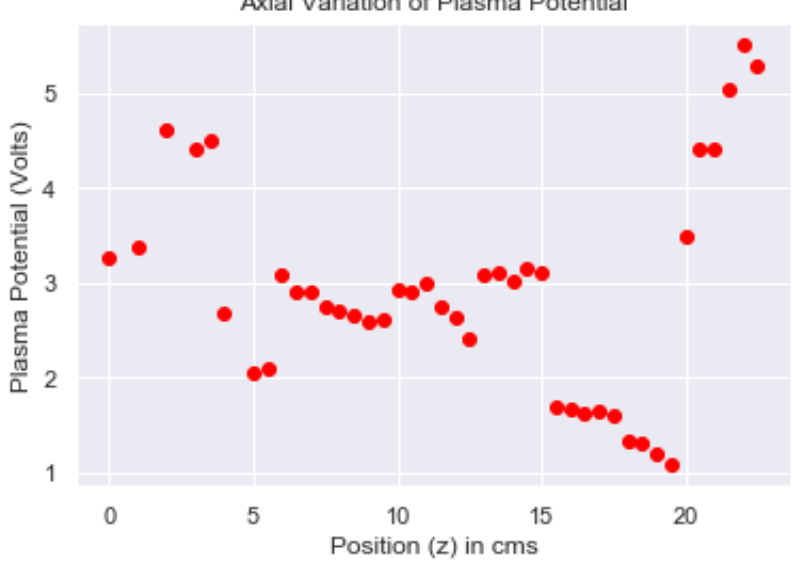
Figure 1. The scattered plasma potential (Volts) values at z=0 to 22 cm locations